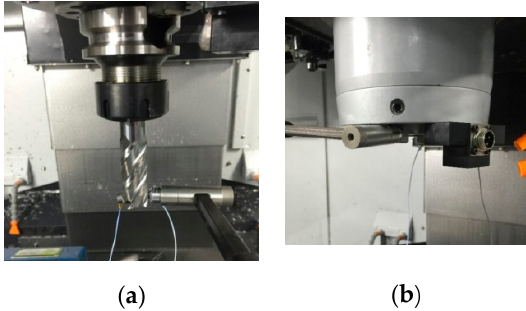
Figure 1. Experimental configurations of vibration test of milling spindle with and without tool holder/cutter. ( a ) Measurement at tool tip. ( b ) Measurement at spindle nose.